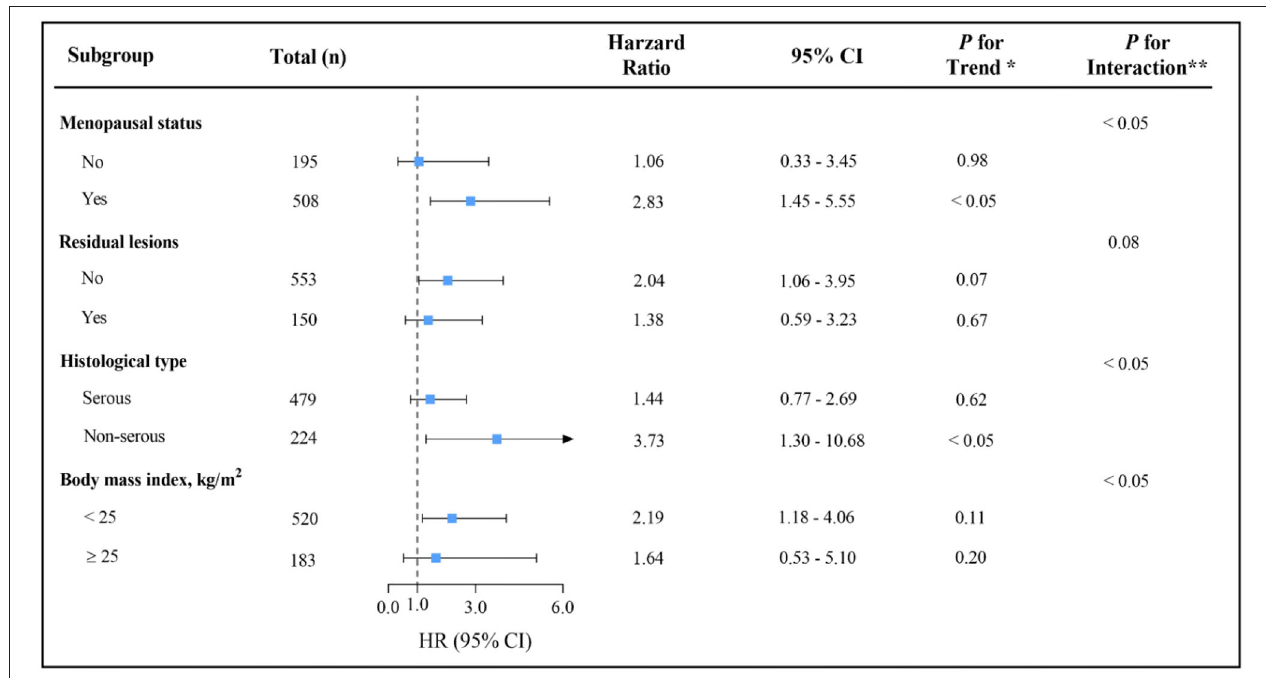
FIGURE 3 | Multivariable hazard ratios (HRs) and 95% CIs for overall survival among ovarian cancer patients across strata of various factors. The analyses used three categories of total dairy intake (T 1 < 14.76, T 2 14.76-90.00 and T 3 ≥ 90.00g/d). The forest plot represents the HRs of the comparison of the highest versus the lowest of dairy intake. Cox model stratified by menopausal status, residual lesions, histological type and body mass index, with additional adjustments for age at diagnosis, comorbidities, diet change, dietary pattern, education, FIGO stage, histopathologic grade, parity, physical activity, smoke status and total energy.* indicates P for trend across levels of total dairy intake.** indicates P for interaction between strata and total dairy intake.